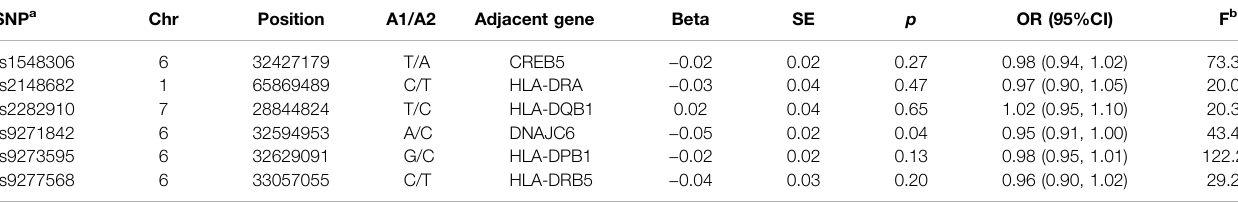
TABLE 1 | Genetic associations of GFD on IBS (at p < 1 × 10 – 5 ).